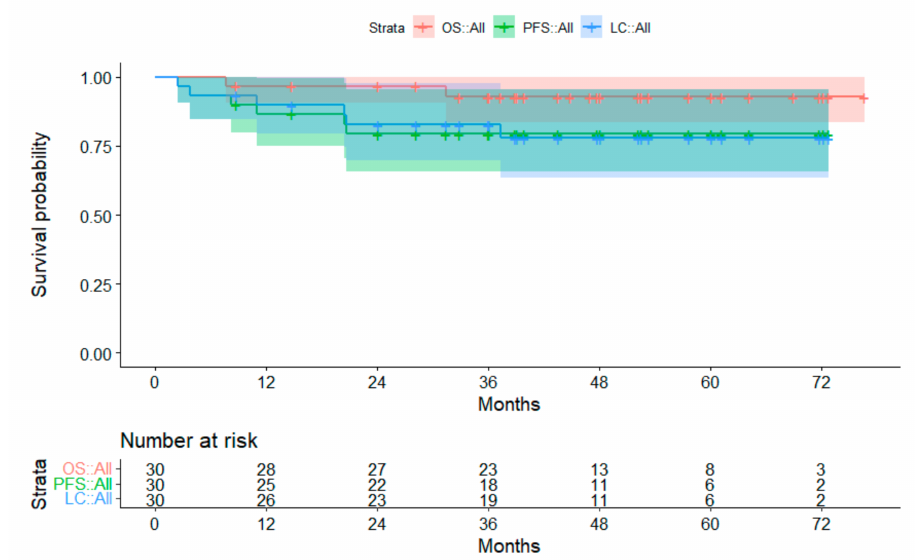
Figure 5. Survival curves for patients with low-grade glioma. The 95% confidence intervals are displayed. Abbreviations: OS = overall survival; PFS = progression-free survival; LC = local